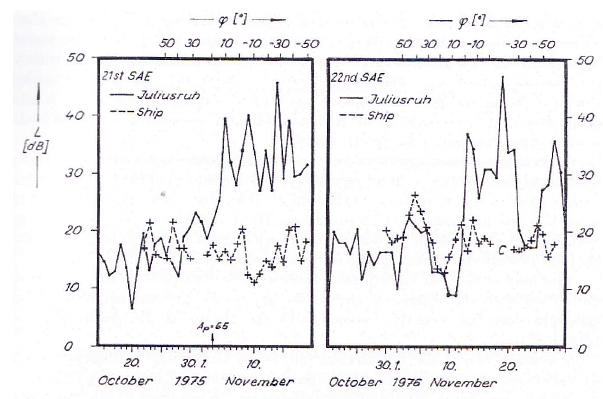
Figure 33. Absorption at 2MHz and cos χ = 0 . 2 ( χ : solar zenith angle) onboard ship and at Juliusruh Station; scales at the top: geo- graphic latitudes of the